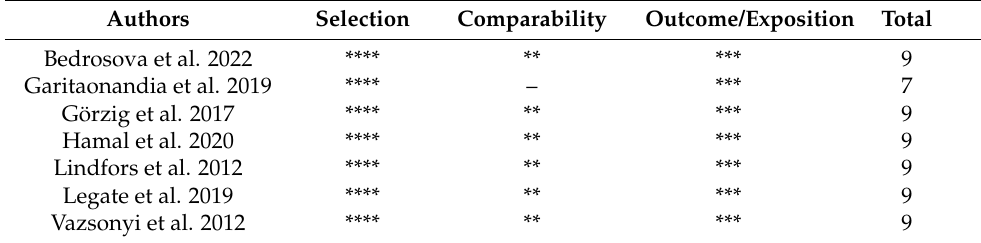
Table 2. Methodological quality evaluation.